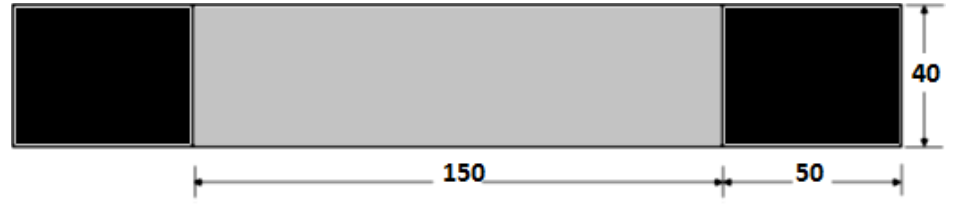
Figure 4. Tensile test specimen geometry (dimensions in mm).